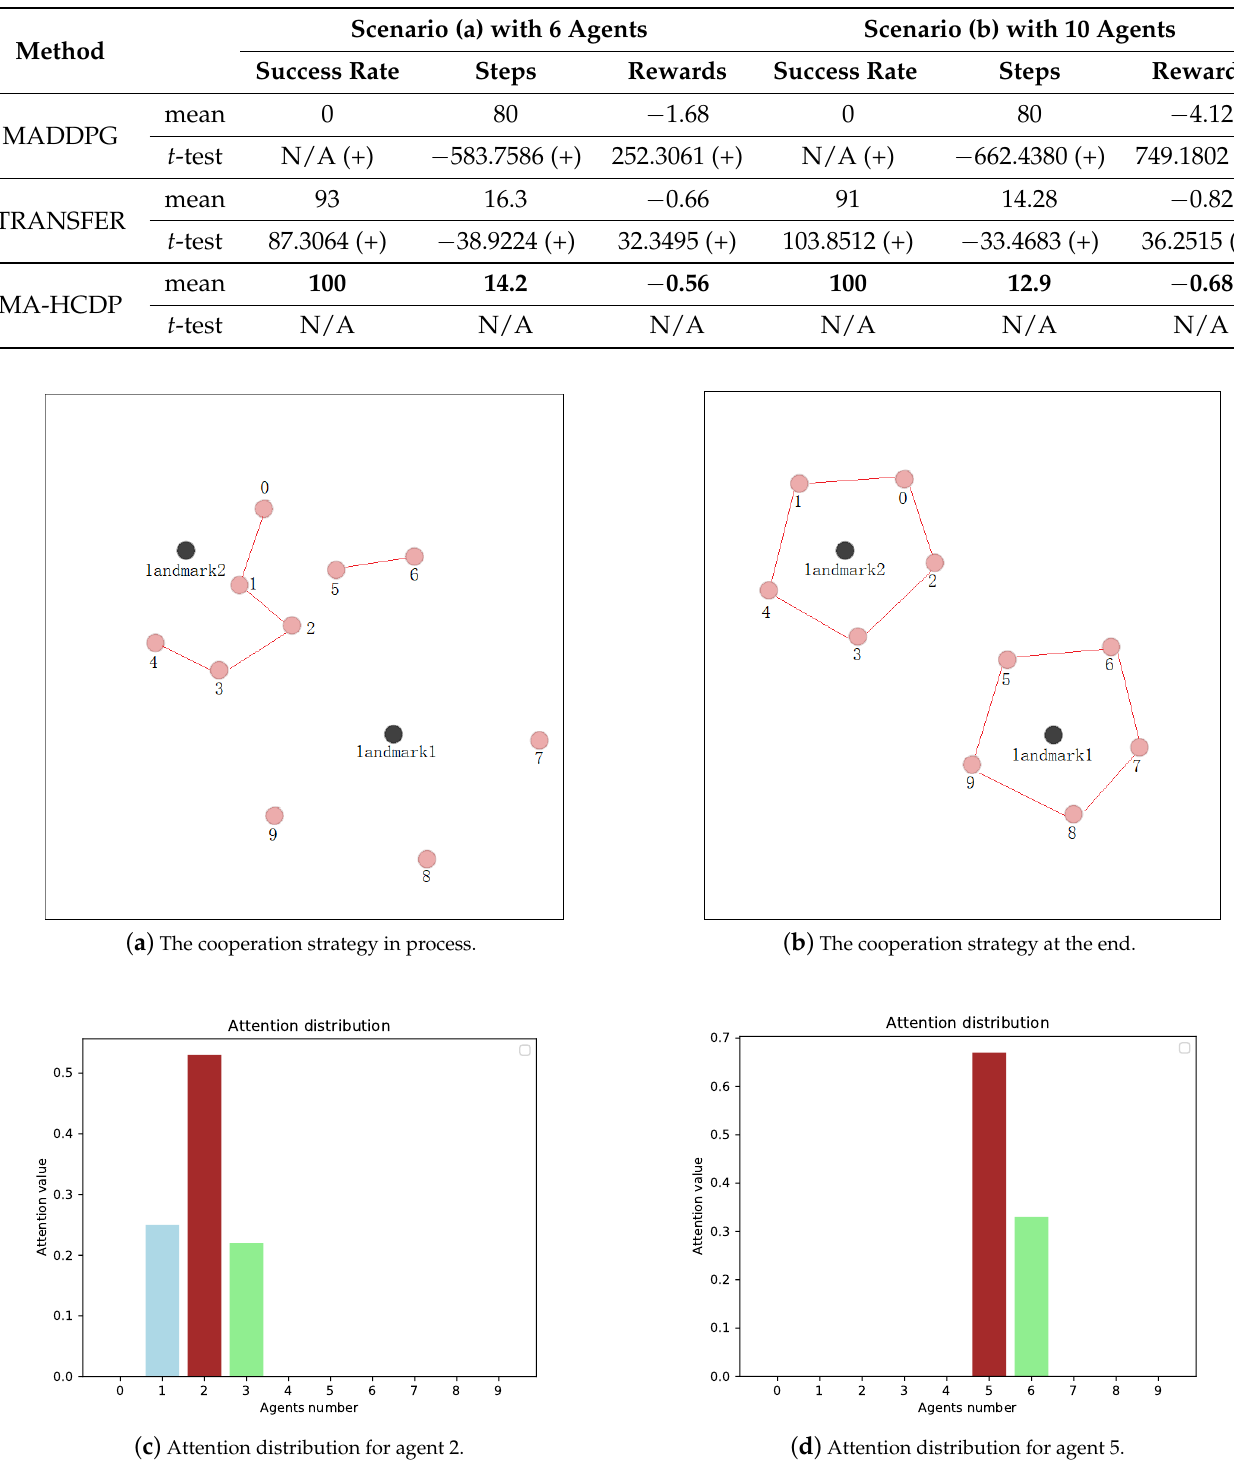
Figure 8. Attention